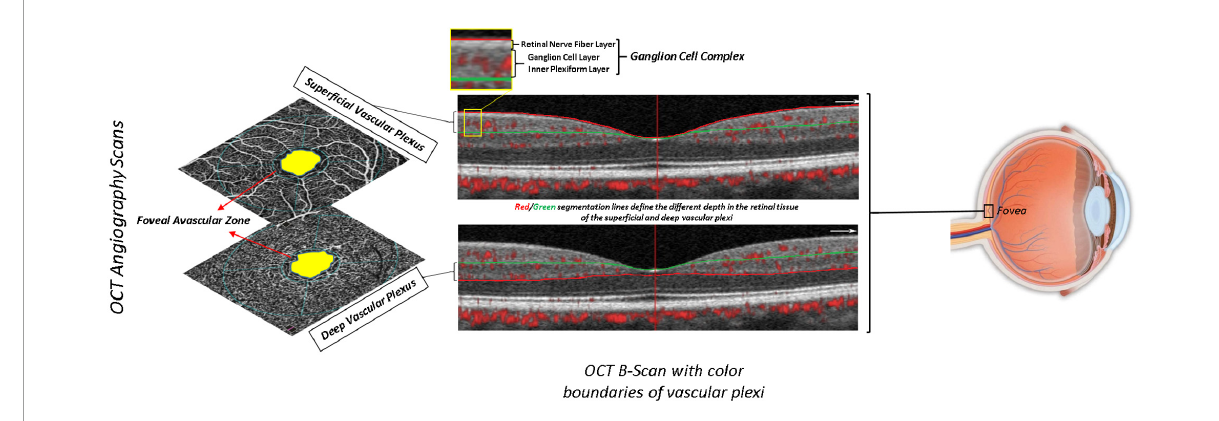
FIGURE1 Retinal features from OCT-A scan (A) and OCT-B scan (B)